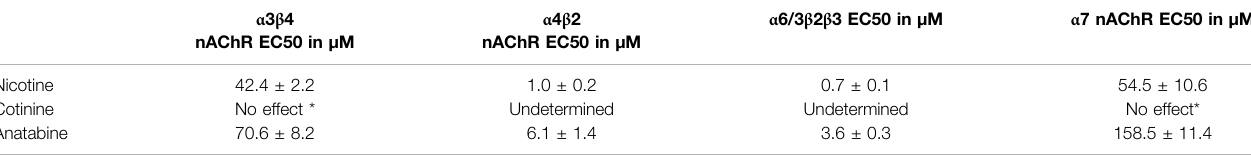
TABLE 1 | The EC 50 values of alkaloids for various nAChR subtypes.